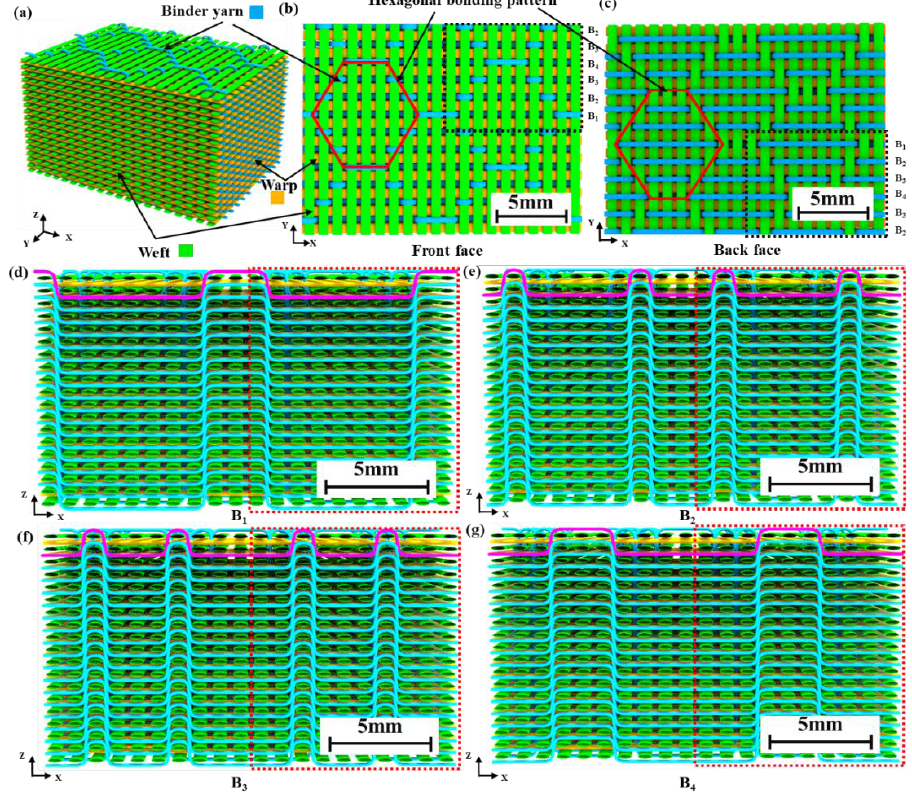
Figure 1. 3D woven architecture with hexagonal bonding pattern: ( a ) isometric drawing; ( b ) front face; ( c ) back face; ( d ) binder yarn B 1 ; ( e ) binder yarn B 2 ; ( f ) binder yarn B 3 ; ( g ) binder yarn B 4 .